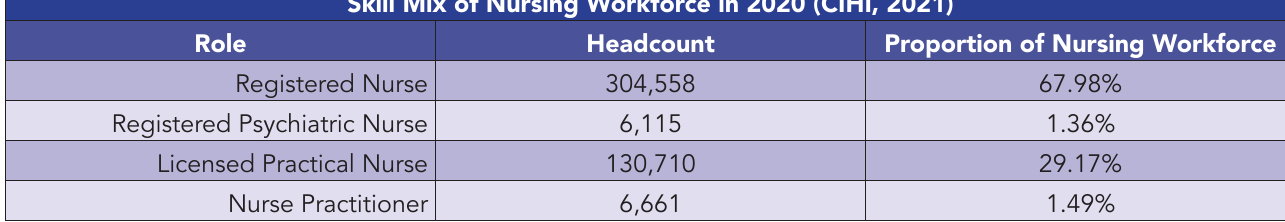
Table 1. The skill mix of the nursing workforce across roles Skill Mix of Nursing Workforce in 2020 (CIHI, 2021)